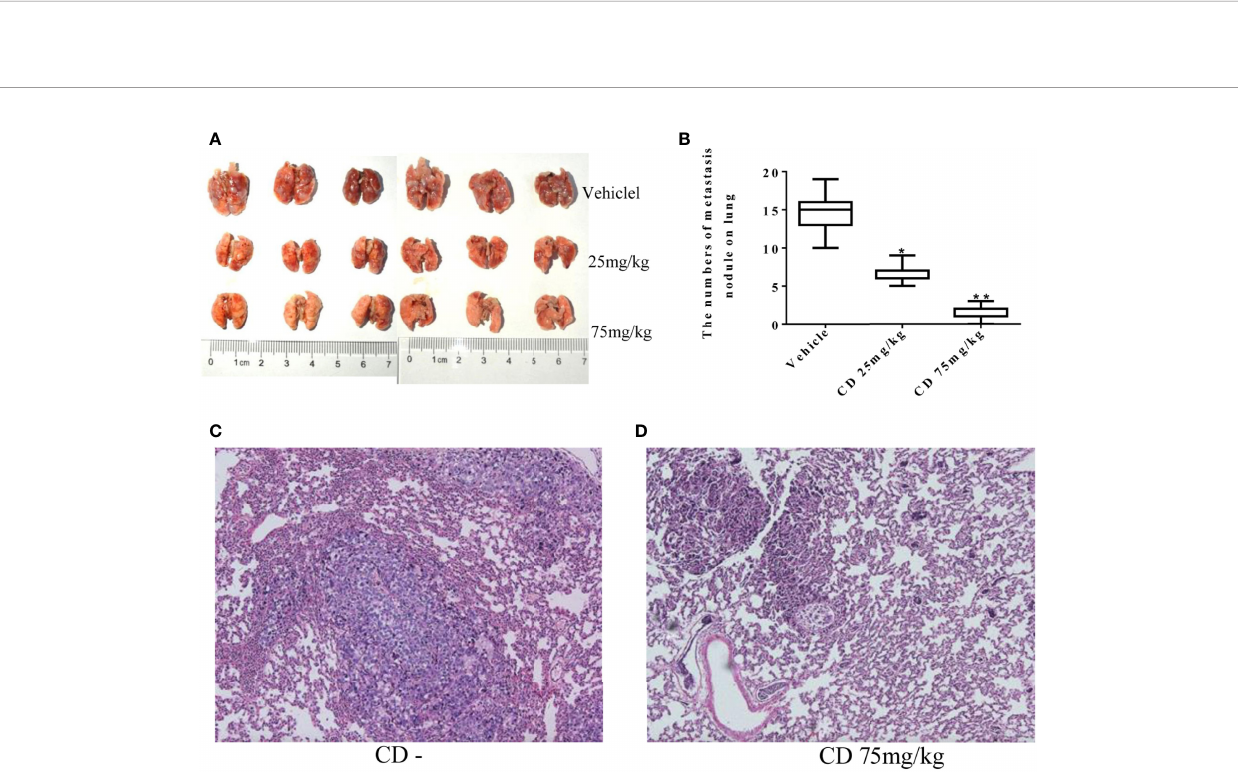
FIGURE 6 | Cordycepin treatment inhibits cancer metastasis to lung. (A) The lung metastasis with different CD treatments. (B) Quantitative data from (A) . (C) H&E staining image results of lung tissues without CD treatments. (D) H&E staining image results of lung tissues with CD treatments. *P < 0.05, **P < 0.01.